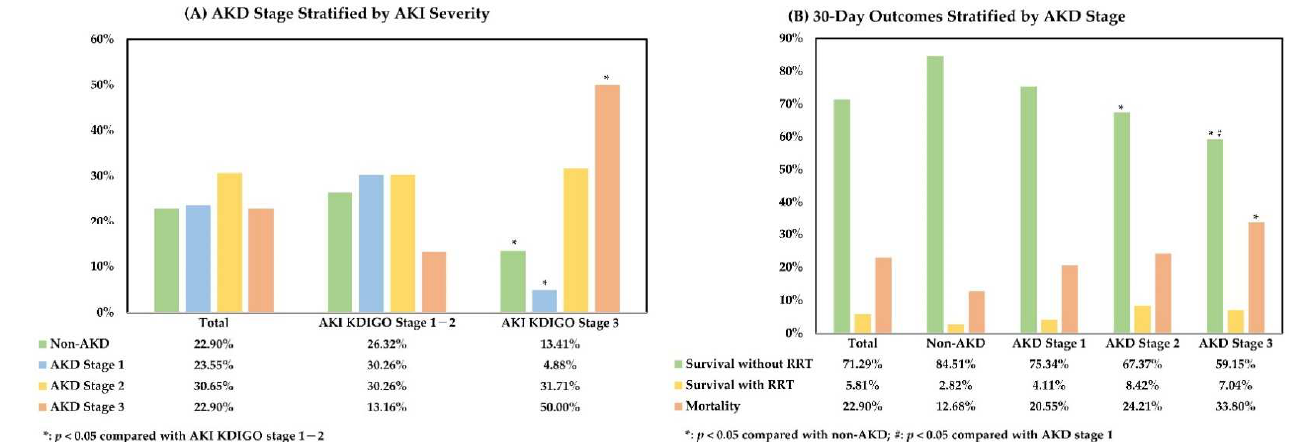
Figure 1. Relationship between AKI severity, AKD stage, and 30-day outcome after AKI. ( A ) . AKD stage stratified by AKI severity; ( B ). 30-day outcomes stratified by AKD stage. All comparisons were performed using the chi-square test. AKD, acute kidney disease; AKI, acute kidney injury; KDIGO, Kidney Disease Improving Global Outcomes criteria; RRT, renal replacement therapy. Kidney Disease Improving Global Outcomes criteria; RRT, renal replacement